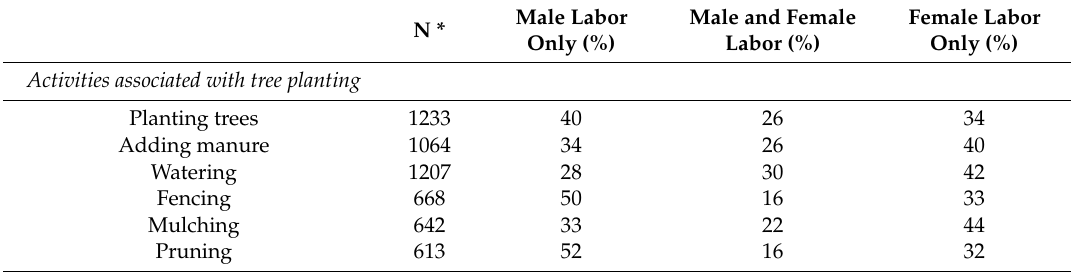
Table 9. Gender of those involved in various management activities associated with tree planting.